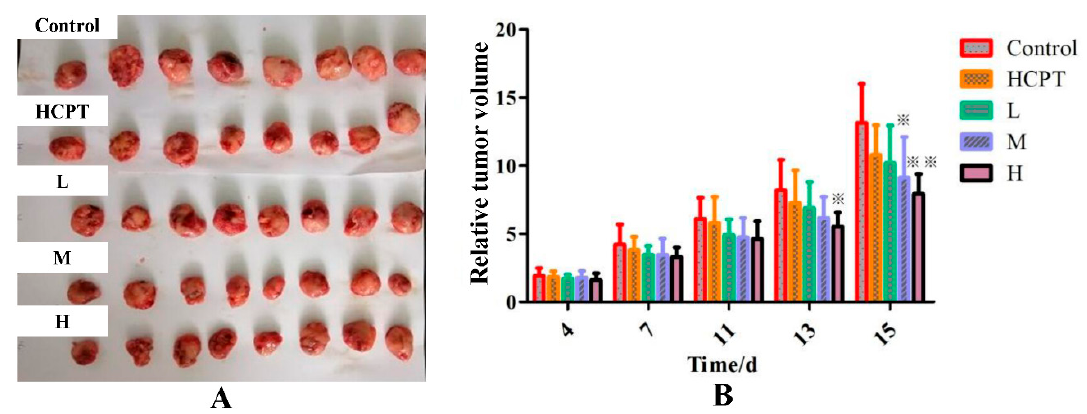
Figure 3. Effect of single or combination of JGGC with HCPT on the tumor growth of Lewis lung carcinoma mice. The photo of tumor collected from different groups of mice at the end of treatment (day 16) ( A ). Relative tumor volume of different groups of mice ( B ). Data are shown as mean ± SD, n = 10. ※ p < 0.05, ※※ p < 0.01 vs. control. L represents low dose group [HCPT (3.9 mg/kg) + JGGC (1.3 g/kg)], M represents medium dose group [HCPT (3.9 mg/kg) + JGGC (2.6 g/kg)], and H represents high dose group [HCPT (3.9 mg/kg) + JGGC (5.2 g/kg)]. Table 5. The relative organ weight (%) of HCPT alone and HCPT combination with JGGC. Group Heart Liver Spleen Lung Kidney Normal 0.53 ± 0.05